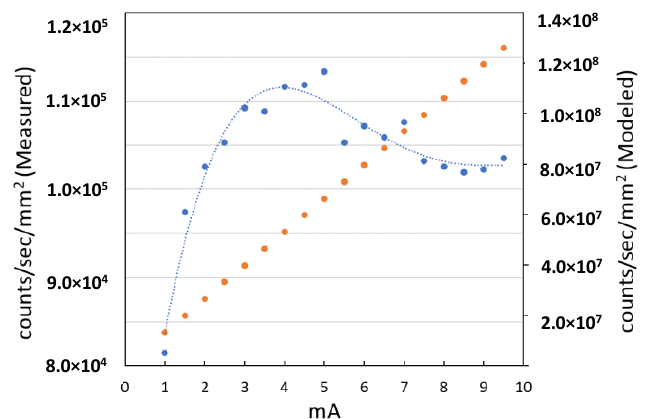
Figure 20. The measured high count rate (blue) by a 4.12 × 5.01 mm 2 CdTe:Cl detector (CRY-3), and modeled count rates (orange) for the X-ray power- generator for the high count-rate measure- ments.